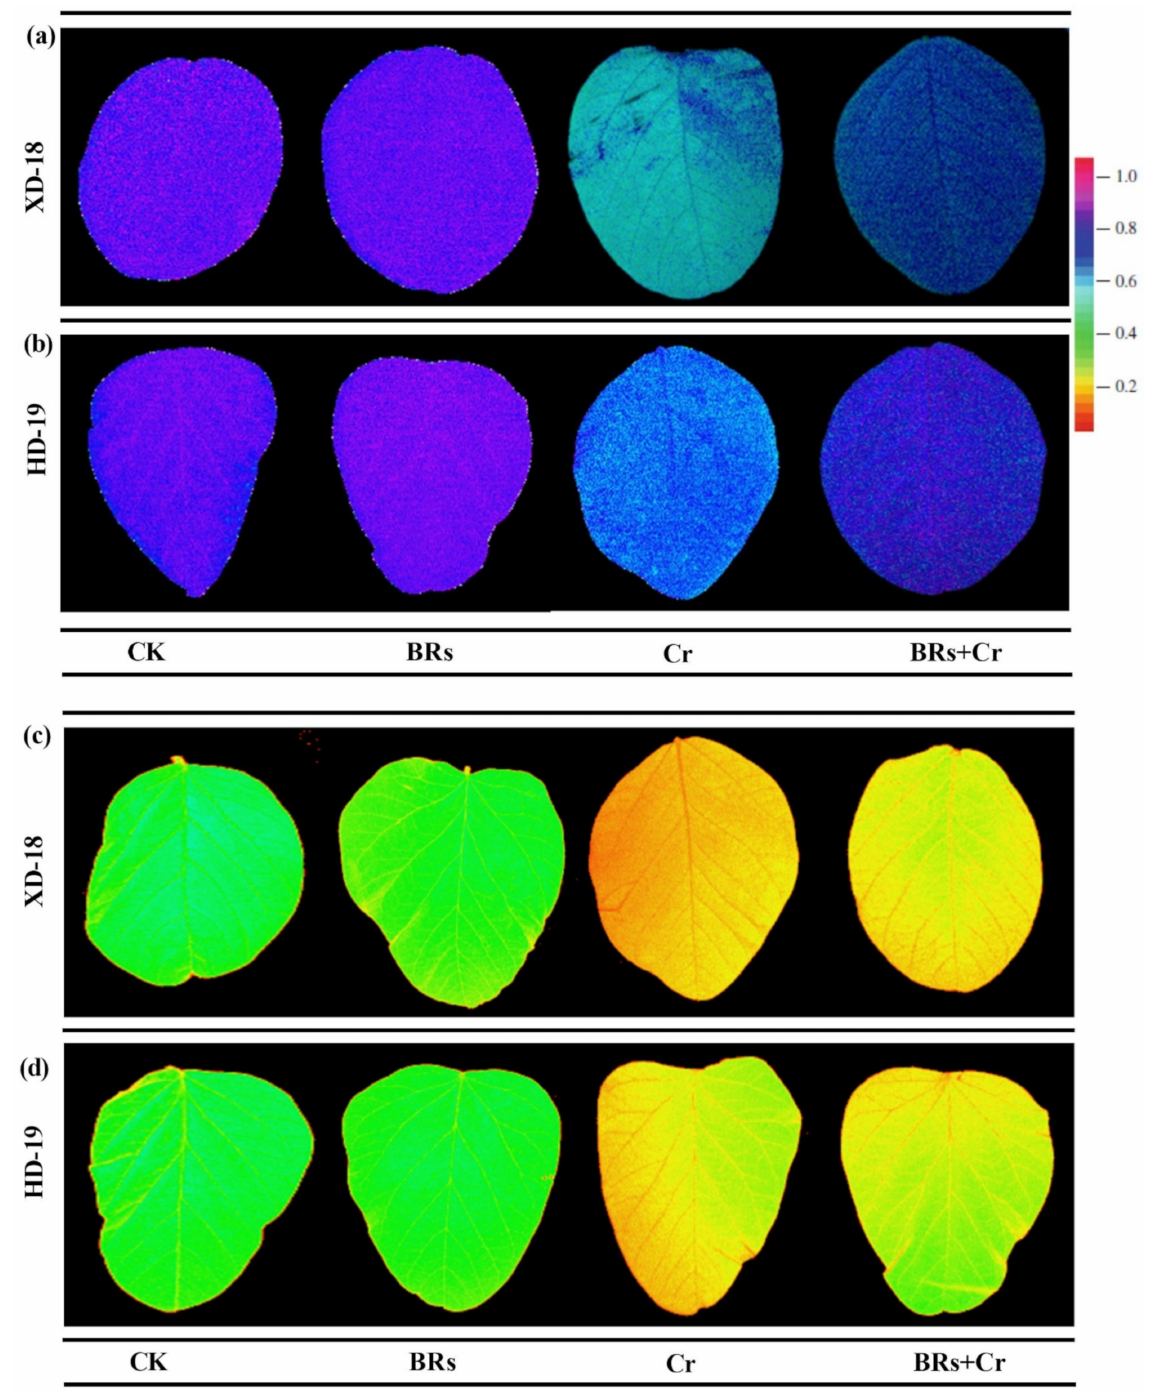
Figure 2. Effect of foliar applied BRs (0.01 µ M) on F v /F m ( a , b ) and F m ( c , d ) levels in the leaves of two soybean genotypes (XD-18 and HD-19) under/without chromium (Cr) (0 and 100 µ M)